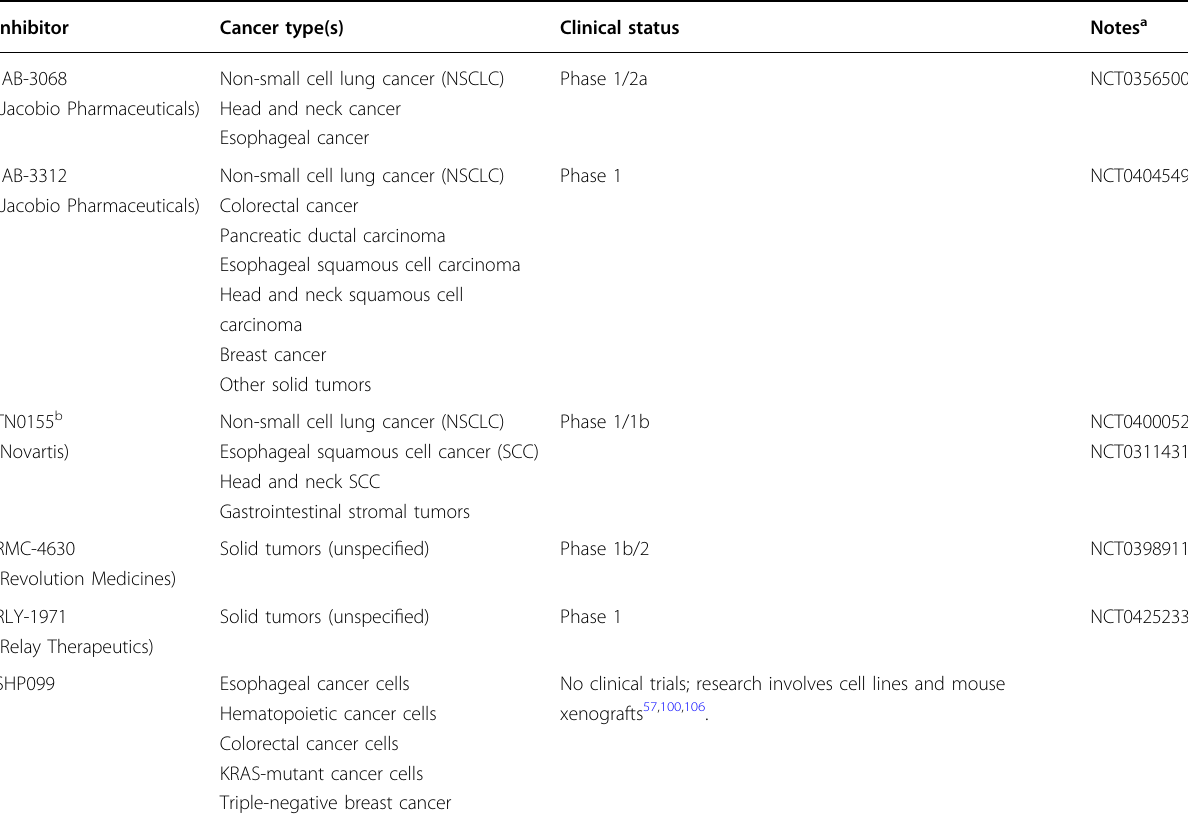
Table 1 Ongoing clinical trials and preclinical studies of SHP2 inhibitors.